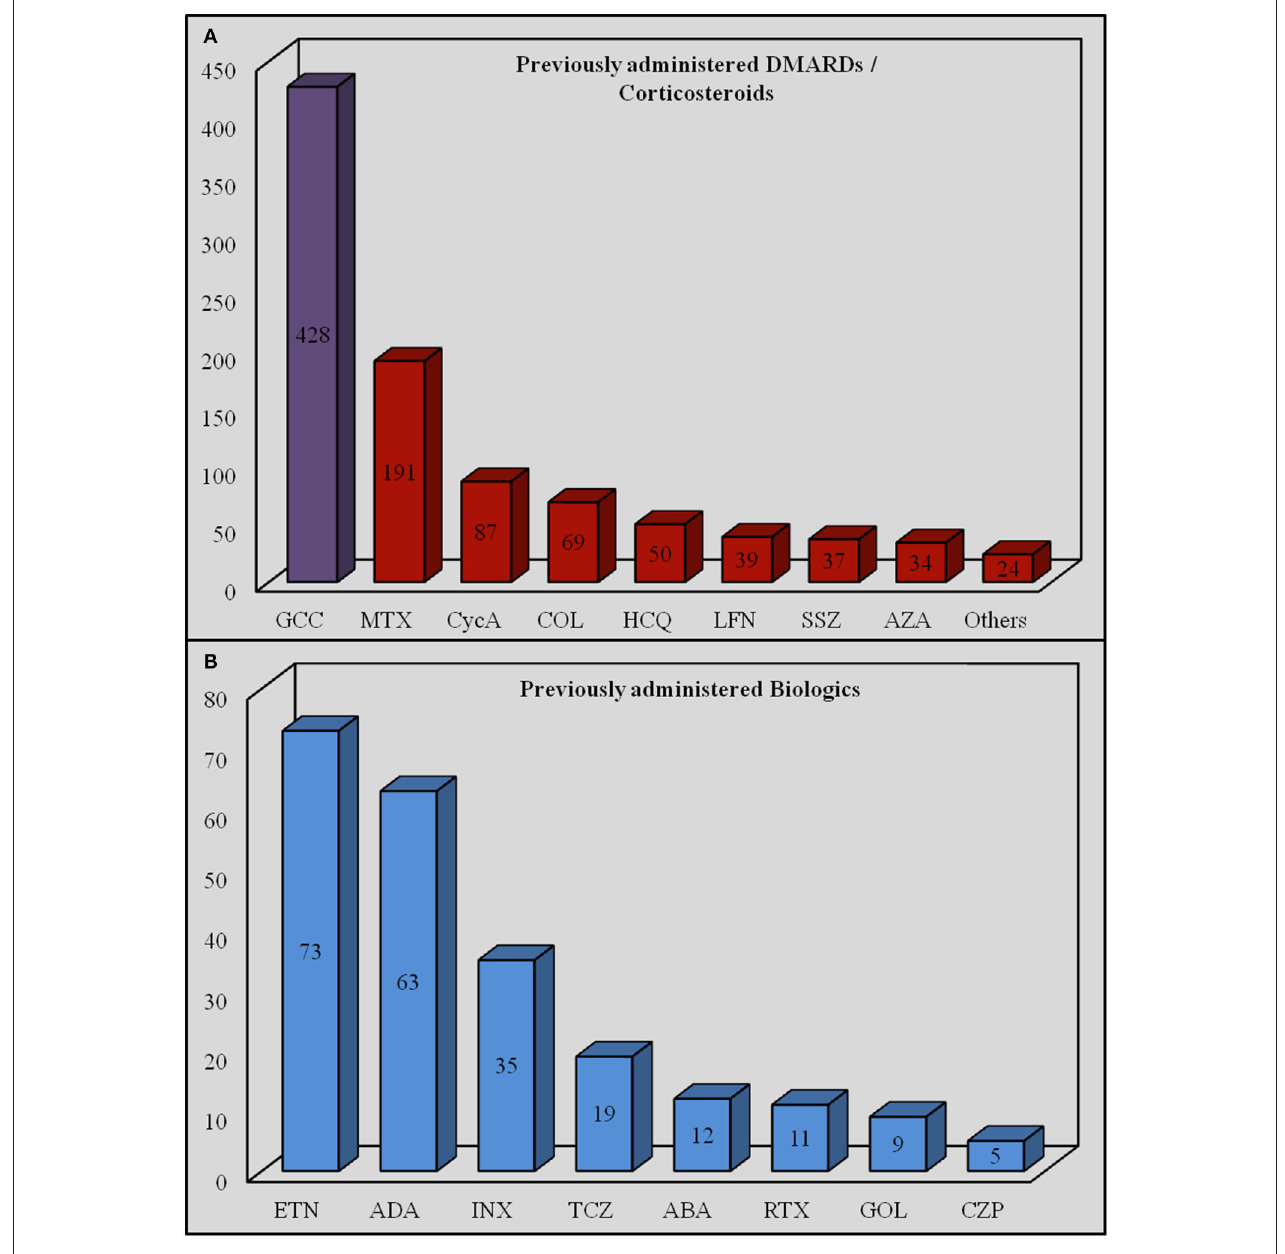
FIGURE 6 | Amount of specific disease modifying antirheumatic drugs/corticosteroids (A) and biologic agents (B) previously administered. ABA, abatacept; ADA, adalimumab; AZA, azathioprine; COL, colchicine; CycA, cyclosporine A; CZP, certolizumab pegol; INX, infliximab; ETN, etanercept; GCC, glucocorticoids; GOL, golimumab; HCQ, hydroxychloroquine; LFN, leflunomide; MTX, methotrexate; RTX, rituximab; SSZ, sulfasalazine; TCZ,